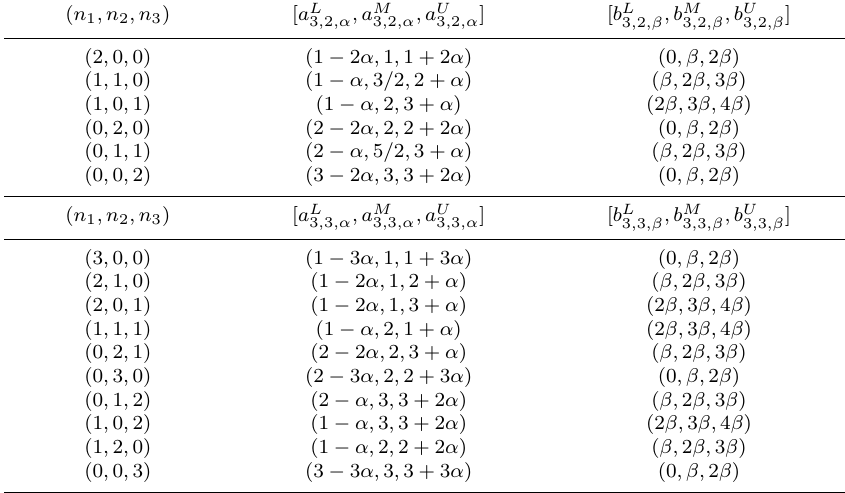
Table 1. Generalized estimates as the components of triangular intuitionistic fuzzy num- bers, calculated for the cases of 2 and 3 experts ( n = 2 , 3). ( n 1 ,n 2 ,n 3 ) [ a L